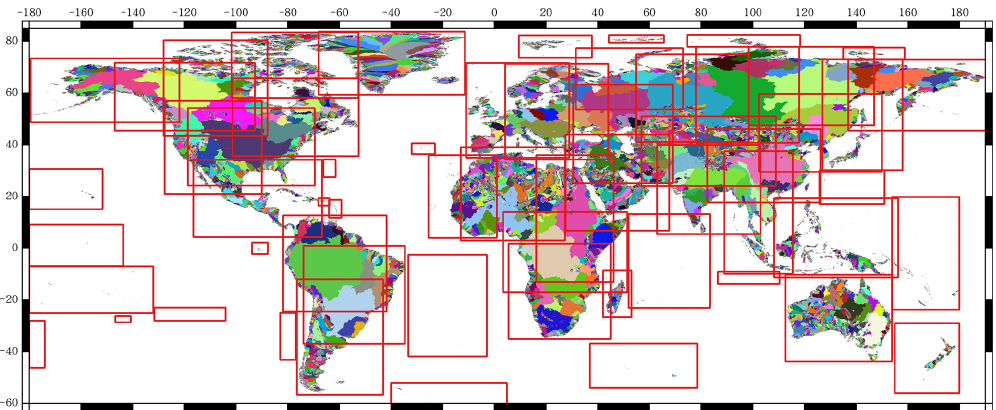
Figure 2. The irregular tiling system (ITS, in red) overlaid with the global drainage basins at 3 × 3arcsec resolution (random colours for illustrative purposes). Within a tile, we retain only the areas that belong to entire drainage basins, so as to preserve lateral and longitudinal connectivity within the basin.